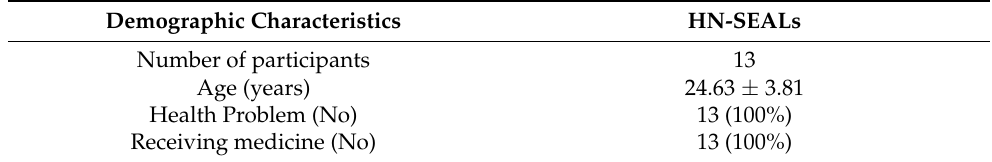
Table 1. Demographic characteristics of participating subjects.